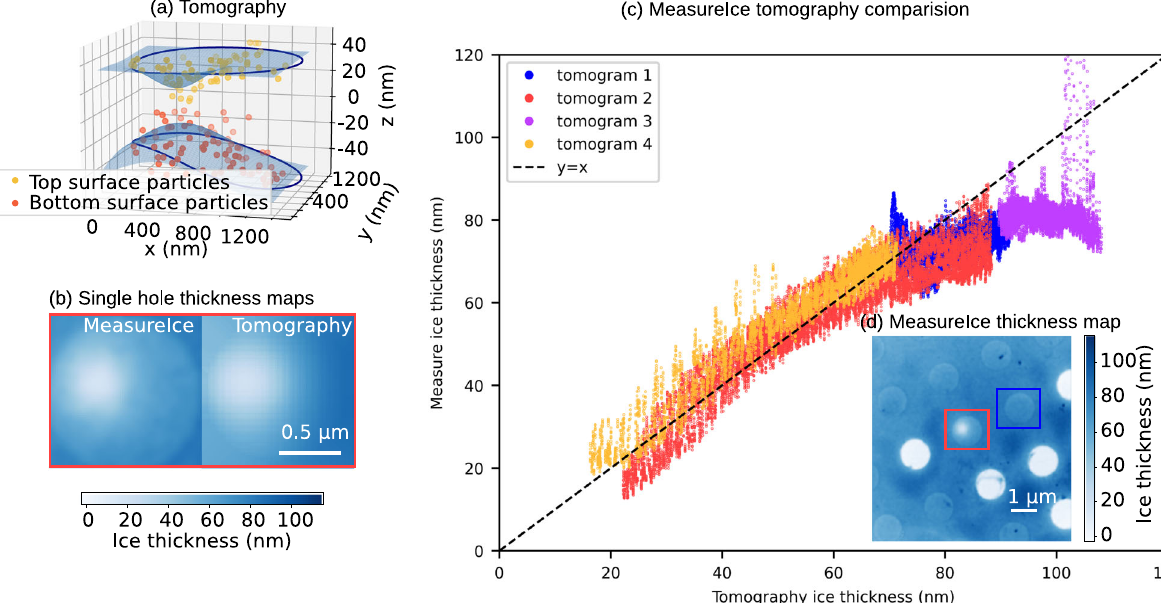
Fig. 3 Benchmarking of MeasureIce with electron tomography. For each hole particles at the extremities in z were manually picked from the grid and a surface fi tted to these points ( a ), the height difference between these two surfaces is taken to be the estimated thickness and this is plotted in ( b ) alongside the same grid hole measured using the MeasureIce approach. Shown in ( c ) is a comparison of ice thickness as measured by tomography and MeasureIce for four different grid holes on an apo-ferritin containing carbon Quantifoil grid. Each datapoint in ( c ) is a single pixel in the MeasureIce thickness map. The MeasureIce thickness map for two of the tomograms is inset in ( d ).